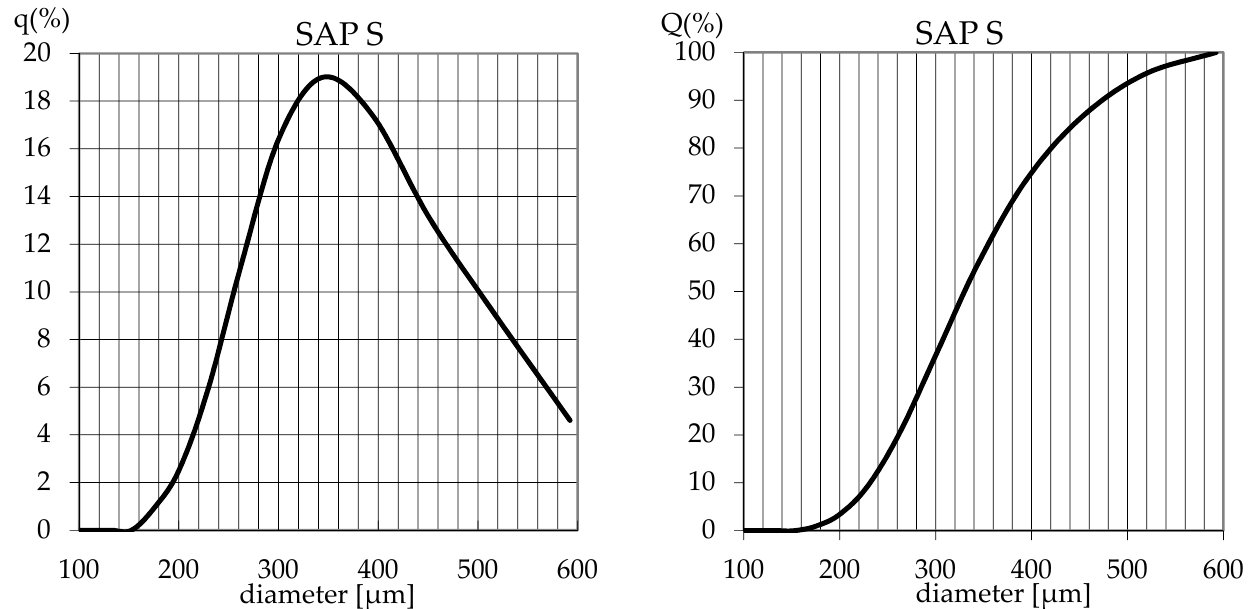
Figure 1. Particle size distribution of SAP S measured through laser diffraction.